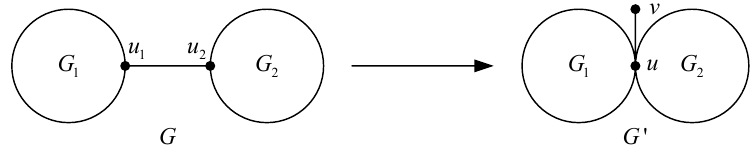
Figure 2. The graphs G and G (cid:48) in Transformation